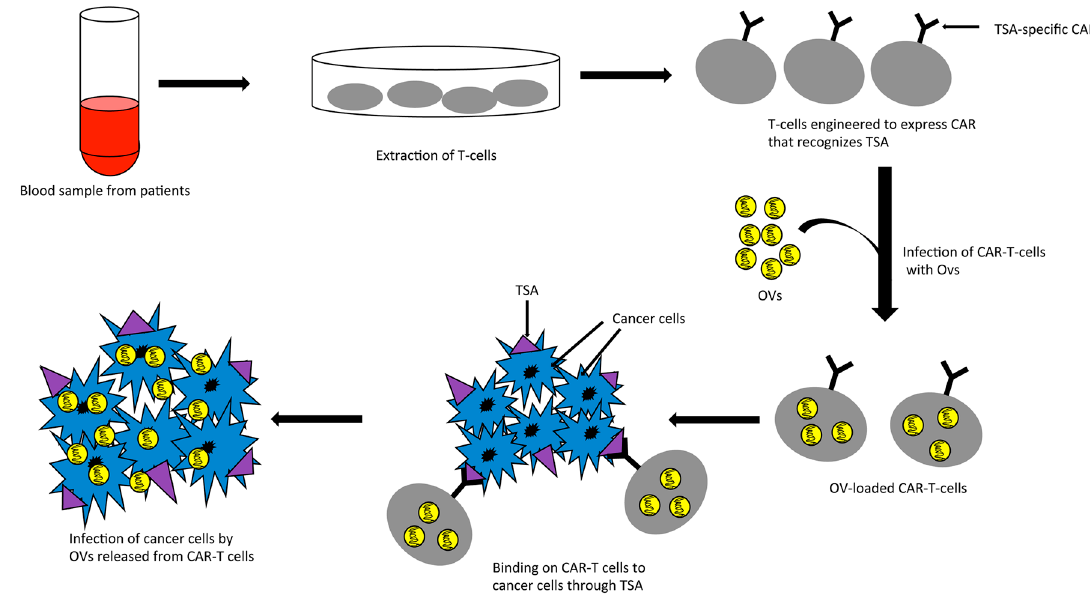
Figure 1. CAR-T cells as carrier for oncolytic viruses. TSA: tumor specific antigen; CAR: chimeric antigen receptor; OVs: oncolytic viruses; CAR-T: CAR expressing T-cells.